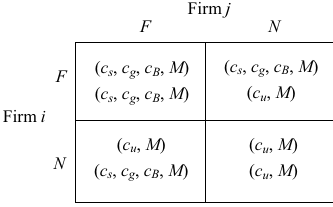
Fig. 4. Symmetric parameterization